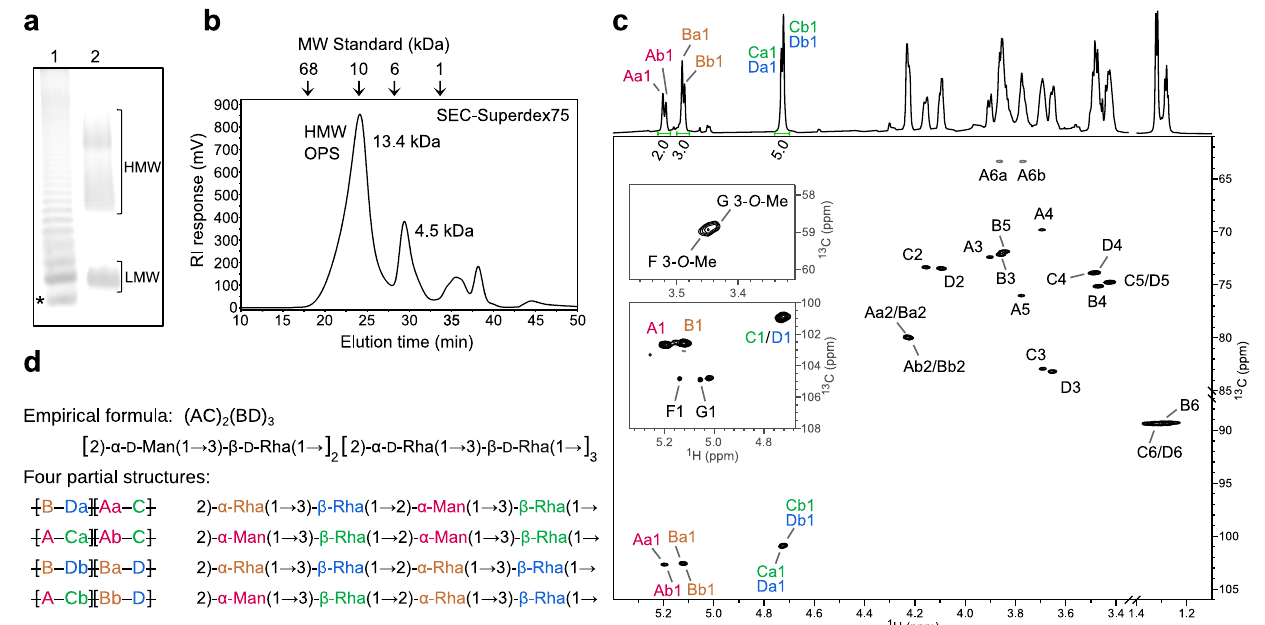
Fig. 1 | Structure of the A. aeolicus O antigen. a Representative SDS-PAGE of A. aeolicus VF5 LPS. Lane 1: Salmonella enterica LPS; Lane 2: A. aeolicus VF5 LPS. In lane 1, the LPS band with the smallest molecular weight is the lipid A-core (*). The subsequent bands above the lipid A-core is lipid A-core with one repeat unit consecutively added after each band. An uncropped gel image is shown as Source Data. b Size exclusion of puri fi ed O antigen. The poly- saccharide elutes at the fi rst peak with an average molecular weight of 13.4 kDa. c Partial 1 H and 1 H, 13 C-HSQC spectra of the released HMW O poly- saccharide chain with signal assignments. Anomeric peak areas are shown